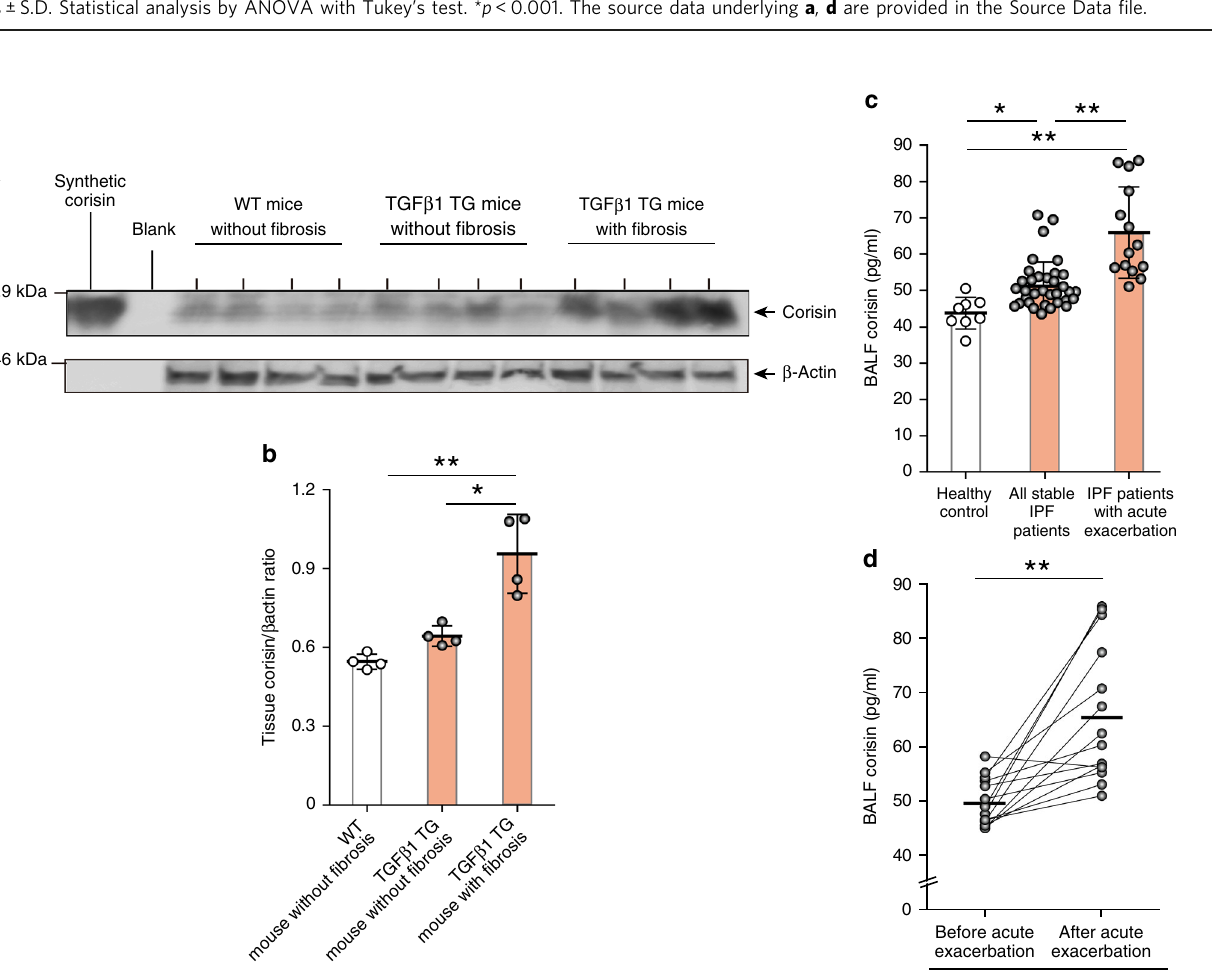
Fig. 7 Intra-pulmonary Instillation of the corisin-containing Staphylococcus nepalensis strain CNDG exacerbates pulmonary fi brosis in hTGF β 1 TG mice. Transforming growth factor (TGF) β 1 transgenic (TG) mice with matched lung fi brosis based on computed tomography (CT) score received intra-tracheal instillation of saline ( n = 4), Staphylococcus epidermidis ATCC14990 ( n = 6), or Staphylococcus nepalensis strain CNDG ( n = 6) as described under methods. a , b The number of cells in bronchoalveolar lavage fl uid (BALF) was counted and then stained with Giemsa on the second day after intra-tracheal instillation of saline or each bacterium. Scale bars indicate 100 µ m. Bars indicate the means ± standard error of the means. Representative microphotographs out of two experiments with similar results are shown. Statistical analysis by ANOVA with Tukey ’ s test. * p < 0.01. c , d DNA fragmentation was evaluated by staining with terminal deoxynucleotidyl transferase dUTP Nick-End Labeling (TUNEL), and then quanti fi ed using the image WinROOF software. Representative microphotographs out of two experiments with similar results are shown. Scale bars indicate 50 µ m. Bars indicate the means ± S.D. Statistical analysis by ANOVA with Tukey ’ s test. * p < 0.001. The source data underlying a , d are provided in the Source Data fi le.